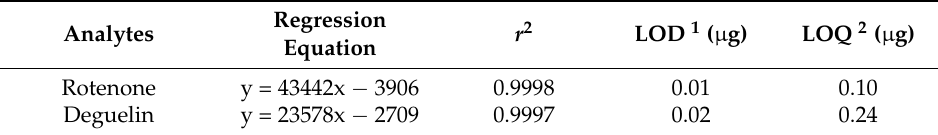
Table 1. Linearity ( r 2 ), regression equation, limit of detection (LOD), and limit of quantitation (LOQ) values of rotenone and deguelin.